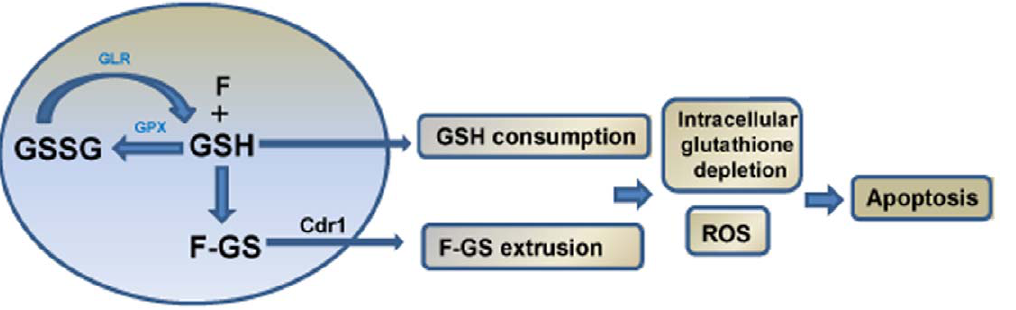
Figure 9. Proposed mechanism of farnesol cytotoxicity in C. albicans . Farnesol conjugates with reduced glutathione (GSH) forming glutathione S-conjugate (F-GS) concomitant with oxidation of GSH to the disulfide form (GSSG), a reaction catalyzed by GPX. GSSG is reduced to GSH by GLR as a recycling mechanism to maintain GSH levels. However, the oxidation and consumption of intracellular GSH coupled with Cdr1p-mediated export of F-GS results in depletion of intracellular GSH, disruption of the redox balance and oxidative stress leading to apoptosis.